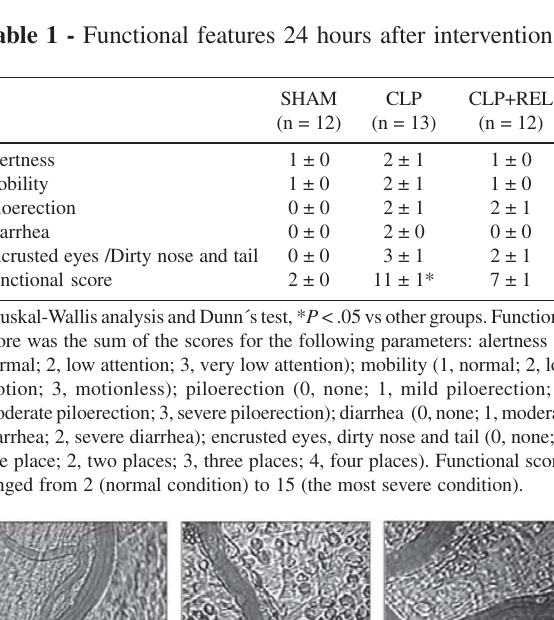
Figure 1 - Representative photomicrographs of rat mesenteric microcirculation from SHAM (SHAM-operated), CLP (cecal ligation/ puncture), and CLP+REL (cecal ligation/puncture and necrotic tissue resection/peritoneal lavage) animals. Increased number of adherent and migrated leukocytes are observed in the CLP in comparison with SHAM and CLP+REL groups. Final magnification: 850x.